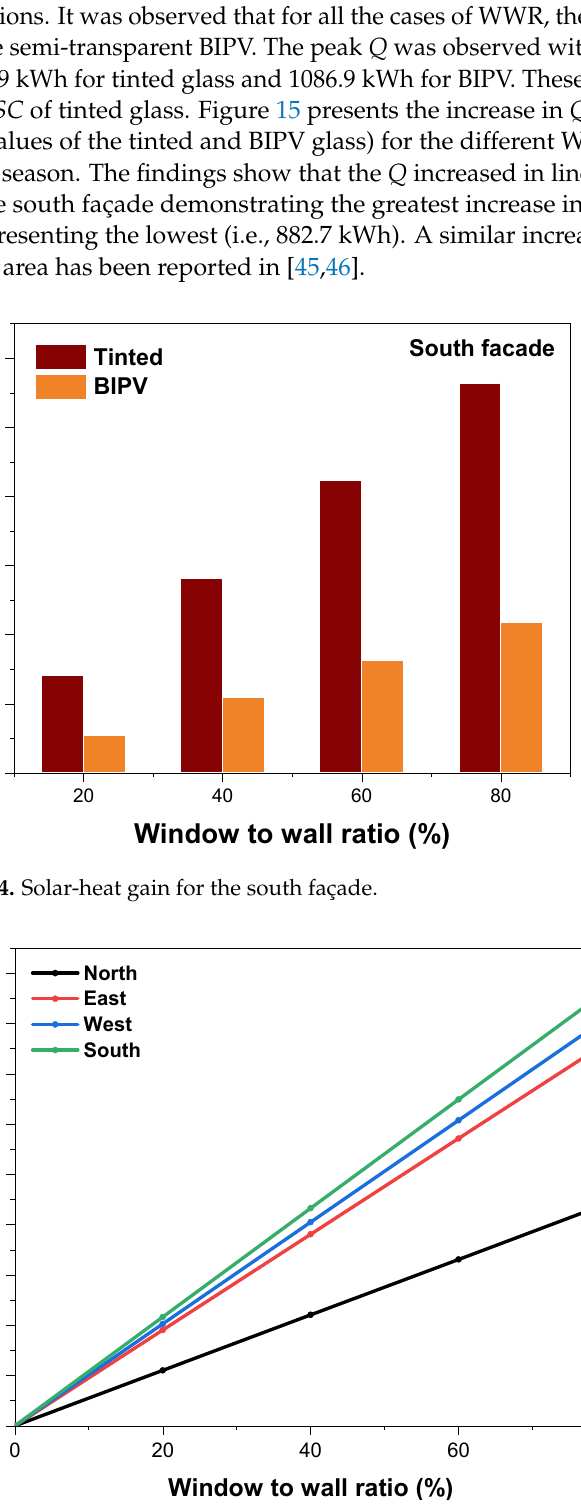
Figure 15. Increase in solar-heat gain along the four principal surfaces.